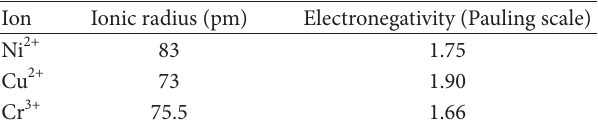
Table 4. e correlation coefficient (0.9280) showed that